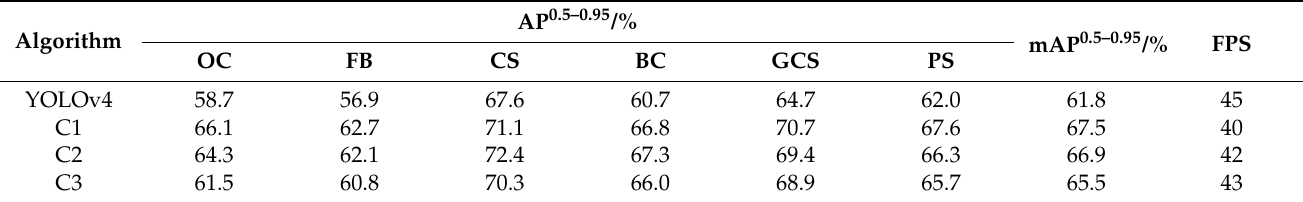
Table 2. Test results of three different embedding